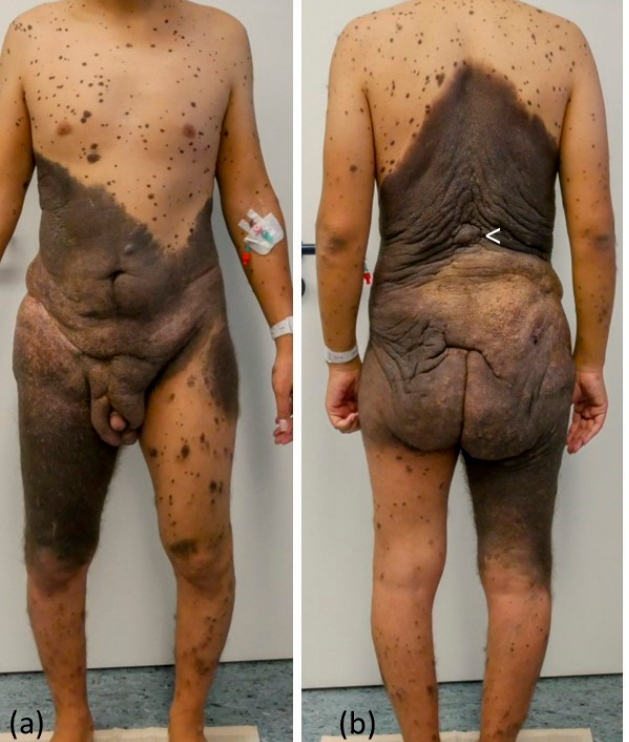
Figure 1. An adult male with congenital giant melanocytic nevus presenting as huge brownish-black partly hairy bathing trunk nevus including several tumorous nodules (arrow head, ( a,b )). Moreover, there were countless satellite nevi on the entire body.